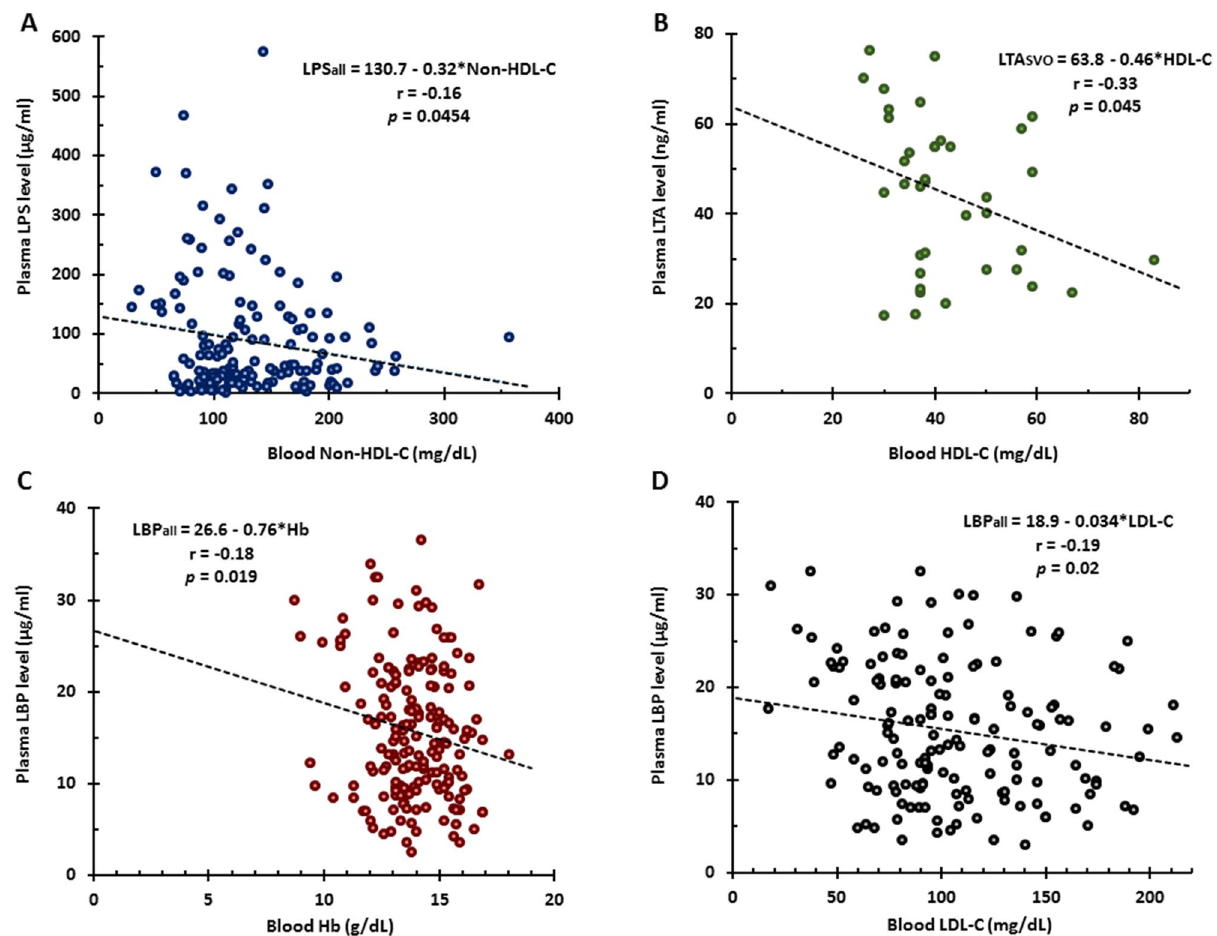
Figure 6. Pearson Correlation Analysis for Non-HDL-C and LPS levels, HDL-C and LTA levels, as well as hemoglobin and LDL-C and LBP levels. Non-HDL-C negatively correlated with plasma LPS levels ( A ). HDL-C negatively correlated with plasma LTA levels ( B ). Hb ( C ) and LDL-C ( D ) negatively correlated with plasma LBP. Hb hemoglobin, LDL-C low density lipoprotein-cholesterol, HDL-C high density lipoprotein-cholesterol, Non HDL-C non high density lipoprotein-cholesterol, LPS lipopolysaccharide, LBP lipopolysaccharide binding protein, LTA Lipoteichoic